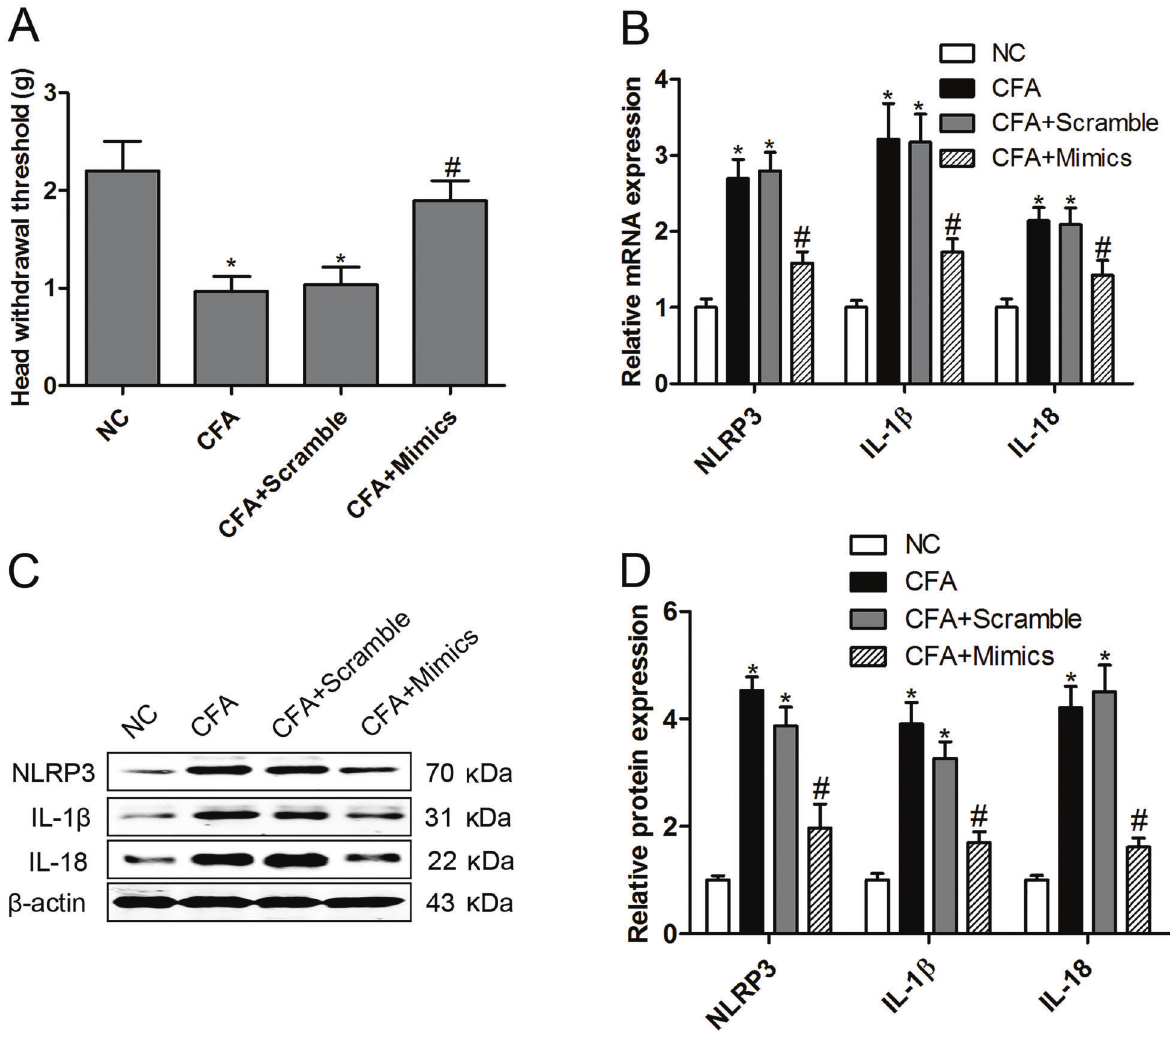
Figure 7. Over-expressed miR-186 alleviated trigeminal neuropathic pain by inhibiting NLRP3 in fl ammasome signaling. In complete Freund ’ s adjuvant (CFA)-injected mice with miR-186 mimics treatment, the head withdrawal thresholds were measured in ipsilateral orofacial regions ( A ). The mRNA expressions of NLRP3, IL-1 b , and IL-18 were measured by RT-qPCR assay ( B ). The protein expressions of NLRP3, IL-1 b , and IL-18 were measured by western blotting ( C, D ). Data are reported as means ± SD for n=6 in each group. *P o 0.05 vs control group (NC); # P o 0.05 vs CFA-injected group (ANOVA followed by a post hoc Tukey ’ s